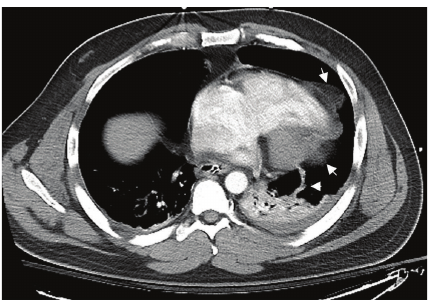
Figure 1: The CT study performed upon emergency department arrival. The heart and mediastinum are dramatically displaced to the left. The heart has migrated posteriorly to rest on the atelectatic left lower lobe of the lung (black arrows). The white arrows demarcate the edges of the pericardium through which the heart has herniated.